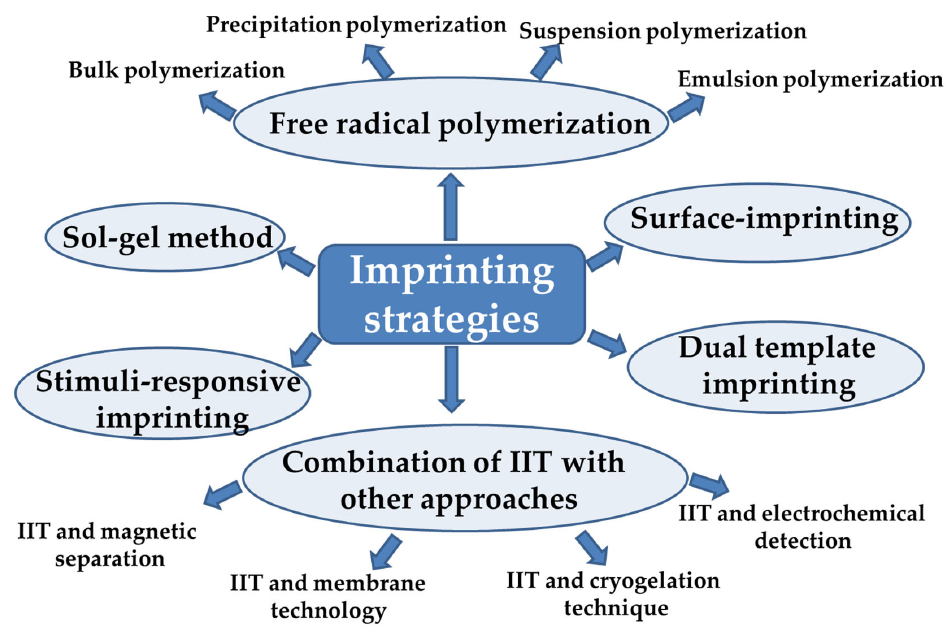
Figure 4. Strategies applied to prepare IIPs materials (IIT is the abbreviation for ion imprinting technology).